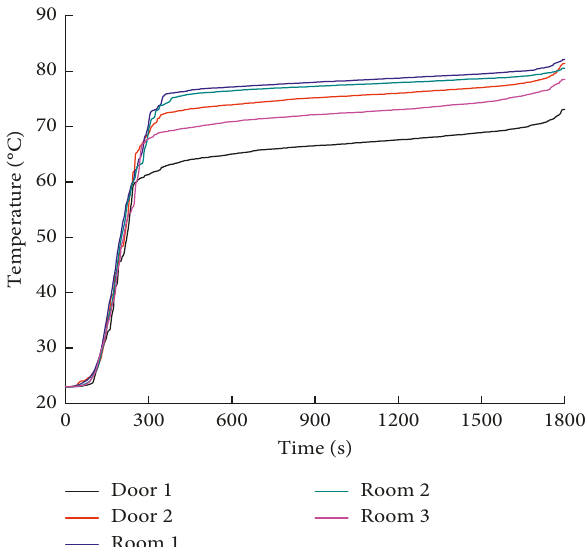
Figure 7: Temperature vs. time inside the room in fire scenario D10.